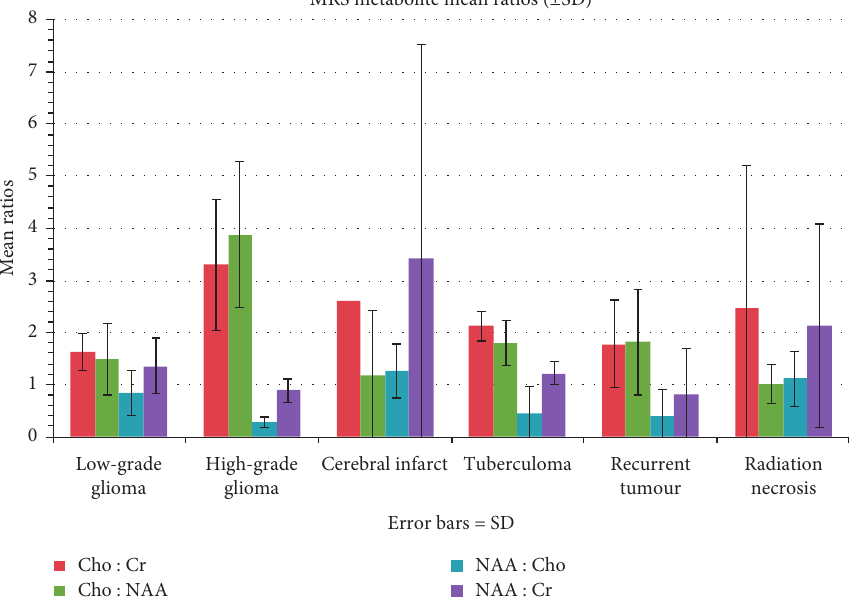
Figure 4: MRS ratios based on the